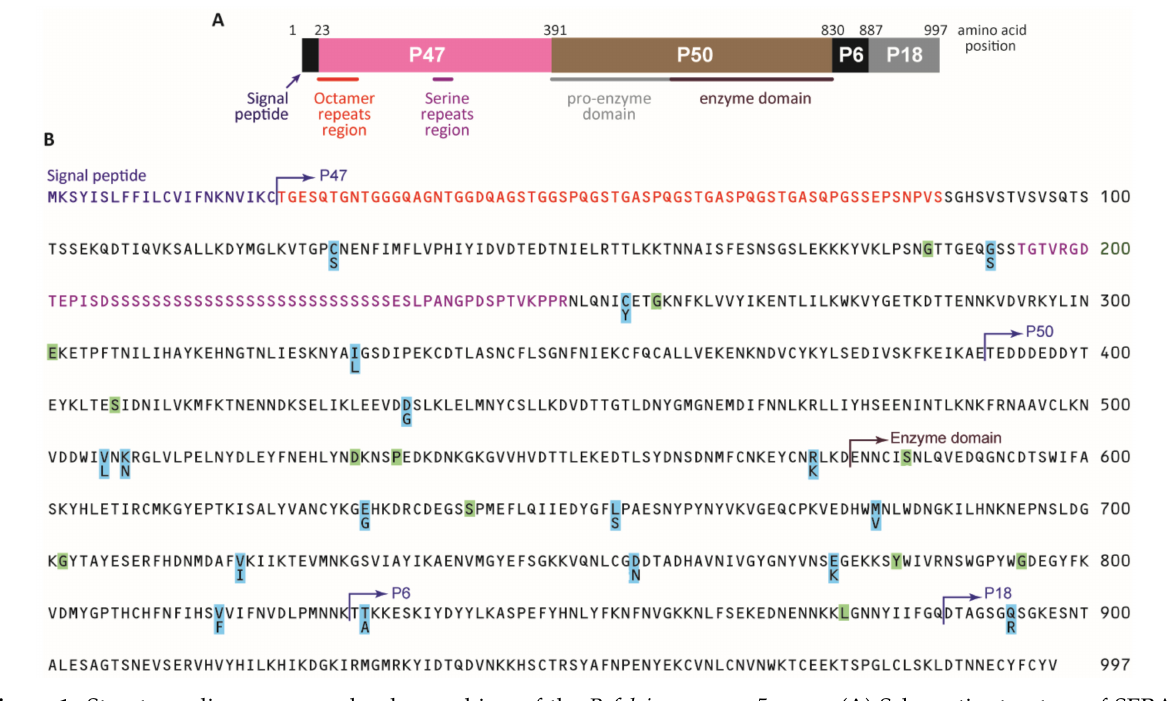
Figure 1. Structure, divergence, and polymorphism of the P. falciparum sera5 gene. ( A ) Schematic structure of SERA5. Numbers are the amino acid positions of SERA5 in the P. falciparum 3D7 strain. ( B ) Amino acid sequence of SERA5 from P. falciparum 3D7. Polymorphic amino acid residues are highlighted in light blue. Positions with synonymous amino acid changes are highlighted in light green. The signal peptide region is shown in purple. Octamer repeats are shown in red. The serine repeat region with a 13-mer insertion/deletion region and a dimorphic 17-mer region are shown in